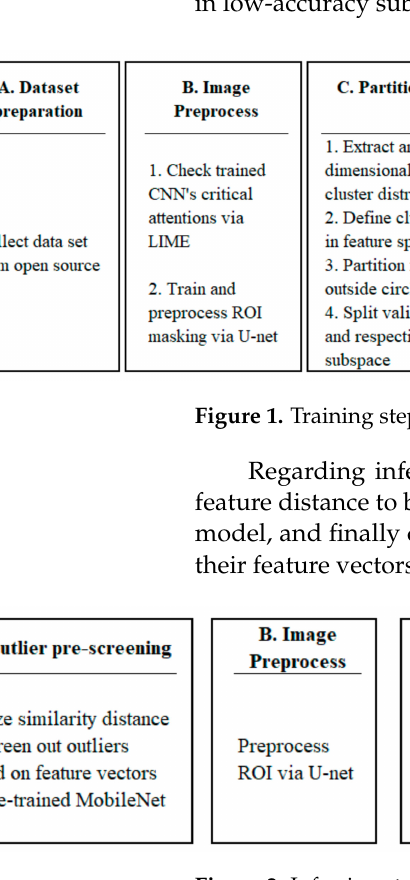
Figure 2. Inferring steps of this